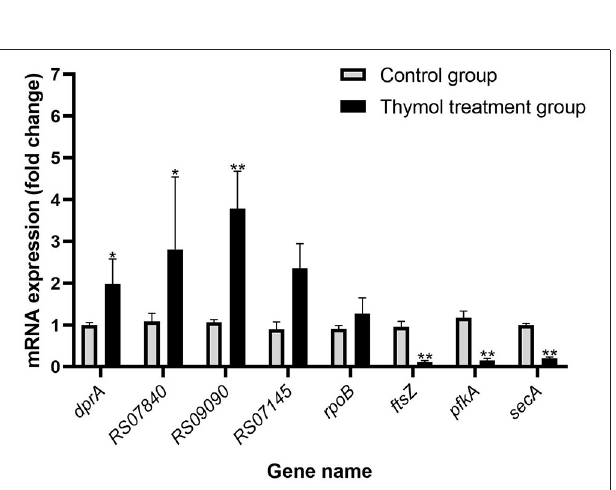
FIGURE 10 | Validation of genes in the two groups by RT-qPCR. All experiments were repeated three times and the results were expressed as mean ± SD. The symbol ** represents an extremely significant difference ( P < 0.01); the symbol * represents a significant difference ( P < 0.05).